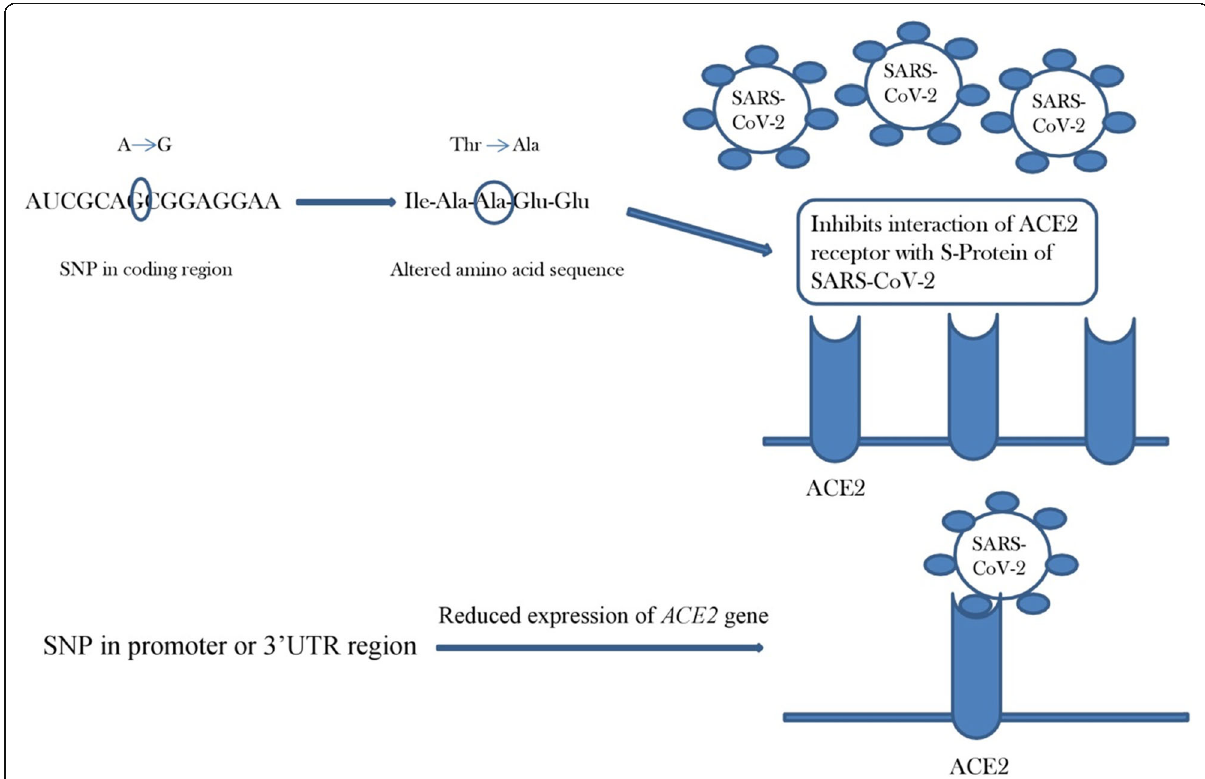
Fig. 3 Possible role of novel ACE2 SNPs in susceptibility towards SARS-CoV-2. Presence of SNPs within coding region can result in alteration of amino acid sequence. This change in amino acid sequence at site of interaction can affect the binding capacity of ACE2 receptor with S-Protein of SARS-CoV-2. Novel SNPs within promoter or 3 ′ -UTR can cause downregulation of ACE2 gene resulting in lower levels of ACE2 receptor at cell surface for interaction with virus